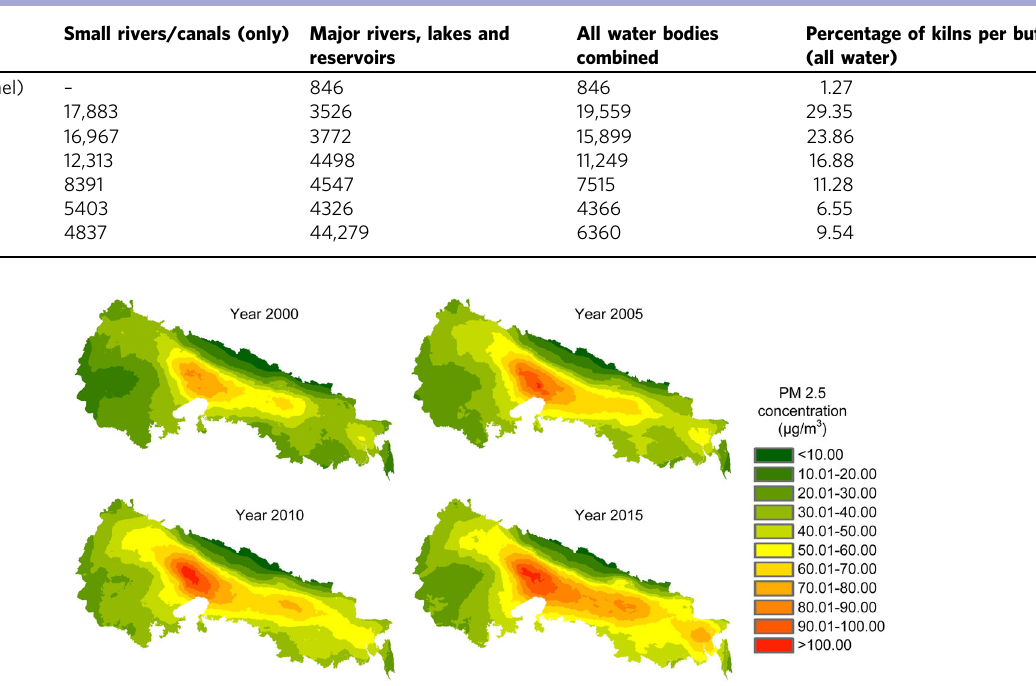
Table 3 Proximity buffers from water bodies across the ‘ Brick Belt ’ to brick kilns in 2018 identi fi ed during the CNN-YOLO mapping process for the cumulative dataset.